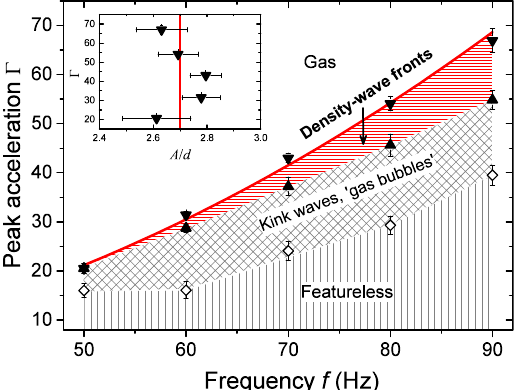
Figure 2. Stability diagram measured by decreasing Γ at various f for h ≈ 3.5 mm and H = 10.7 mm. DWFs are observed in the hysteresis region of the transition between the gas-like state (Gas) and kink-wave fronts or “gas bubbles”. Inset: onset of DWFs in the Γ - A plane. The red line corresponds to A = 2.7 d , which is the mean value of the onset at various f . The mass of the sample and the liquid content are m = 113 g and W = 1.5%,